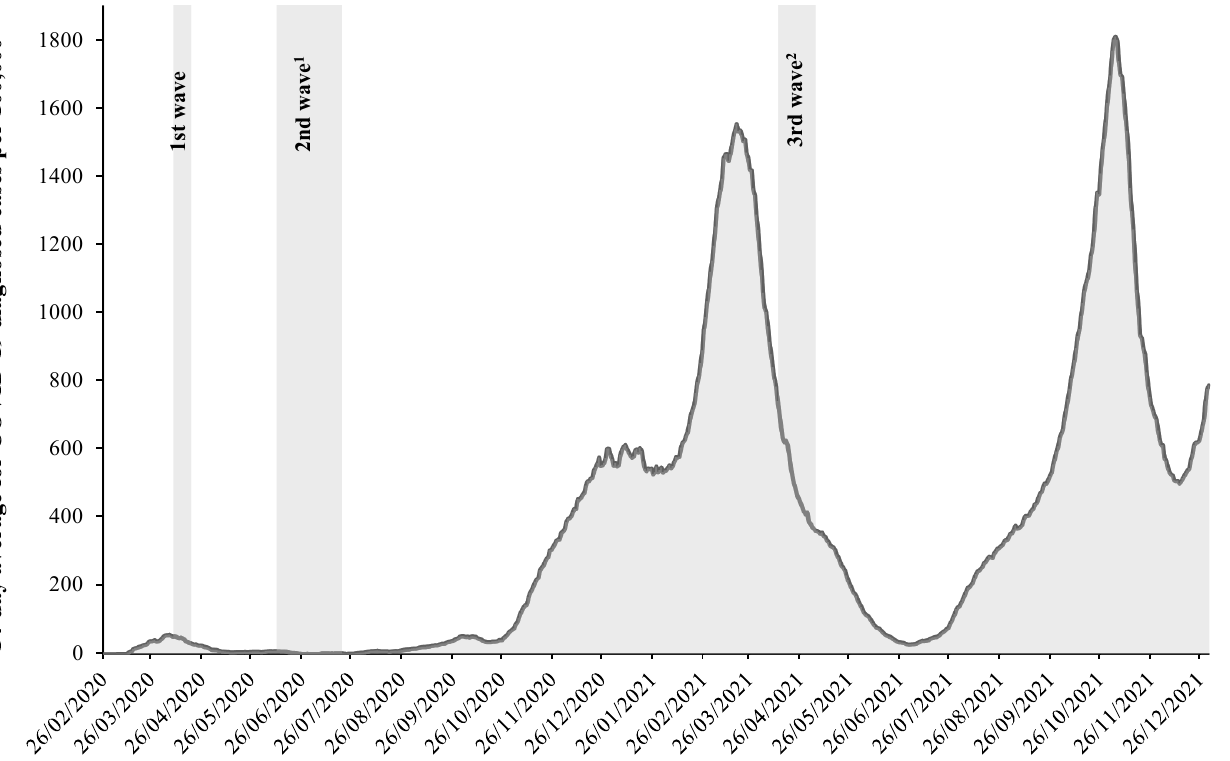
Figure 1. Survey periods and 14-day average incidence rates for COVID-19 in Estonia, 2020–2021 [24]. 1 HRQoL baseline measuring; 2 HRQoL follow-up measuring.